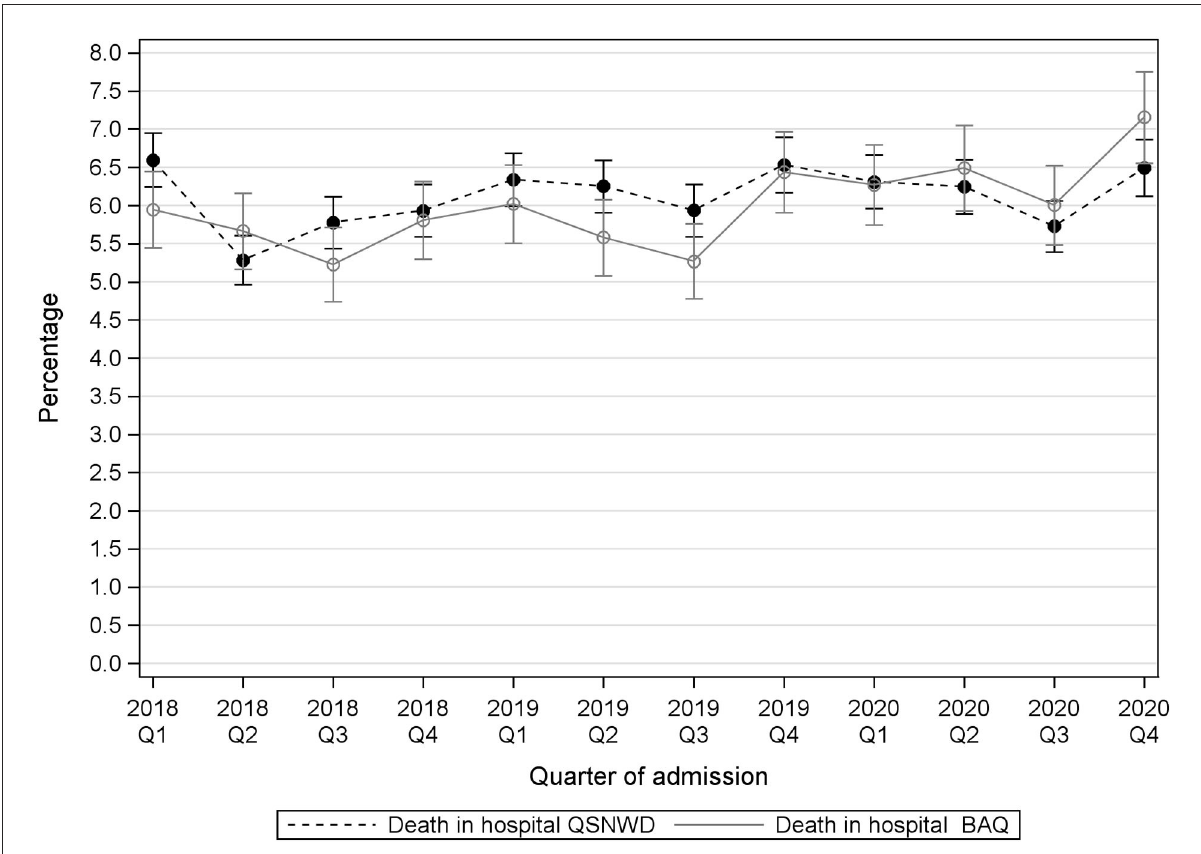
FIGURE4 Death in hospitalized patients with cerebral infarction (ICD-10 I63) from the registries QSNWD (dashed line) and BAQ (solid line) in 2018–2020 by quarter of admission.